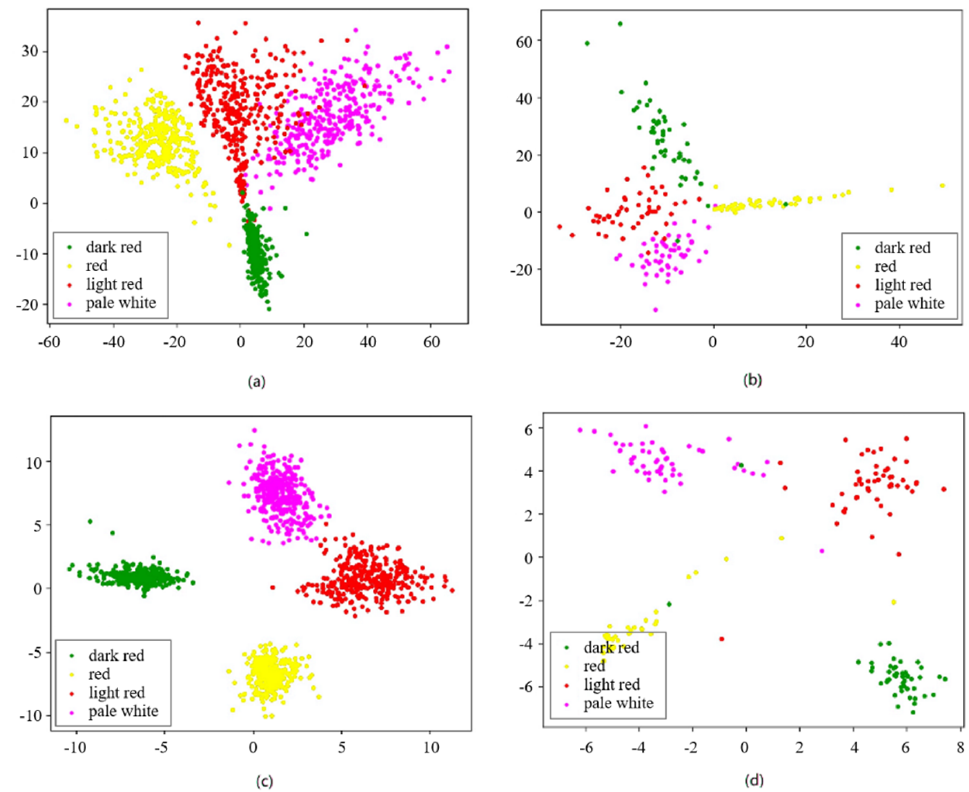
Figure 13. The distribution of learned features: ( a ) the training set without center loss; ( b ) the validation set without center loss; ( c ) the training set with center loss; ( d ) the validation set with center loss.